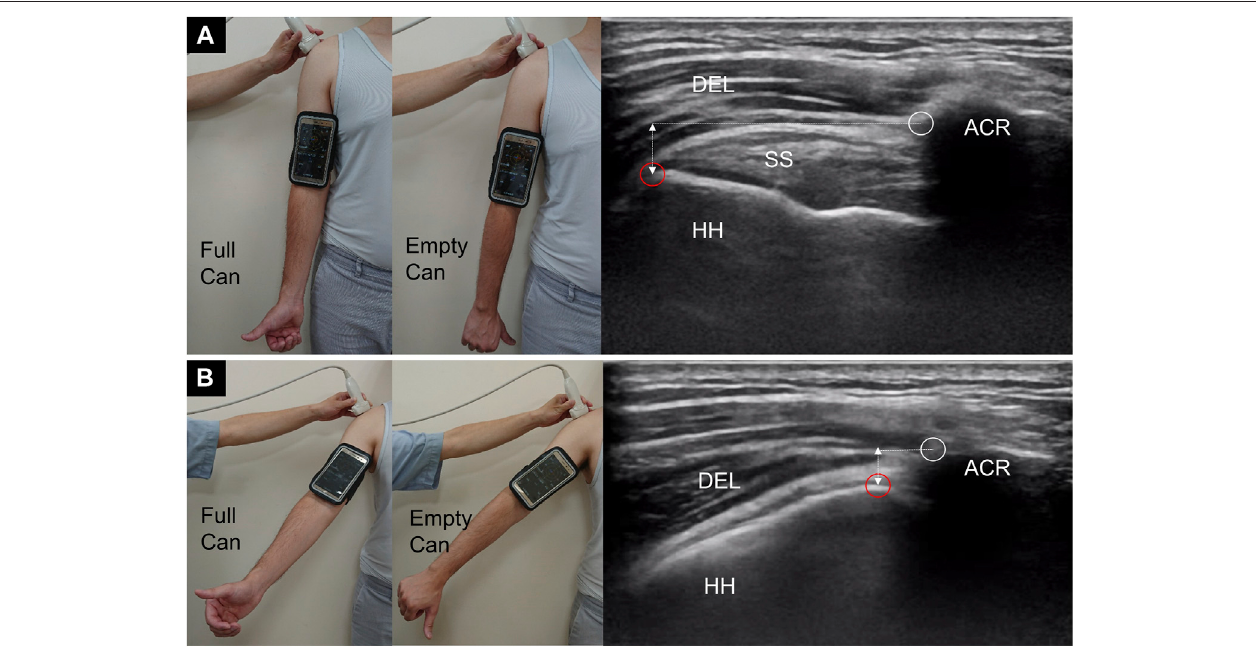
FIGURE 1 | The posture of the upper extremity and ultrasound imaging of the subacromial region at the starting (A) and abducted (B) position. In (B) , the greater tuberosity (red circles) is about to pass the lateral acromial edge (white circles). DEL, deltoid muscle; HH, humeral head; SS, supraspinatus tendon; ACR, acromion; double-head dashed line, vertical acromiohumeral